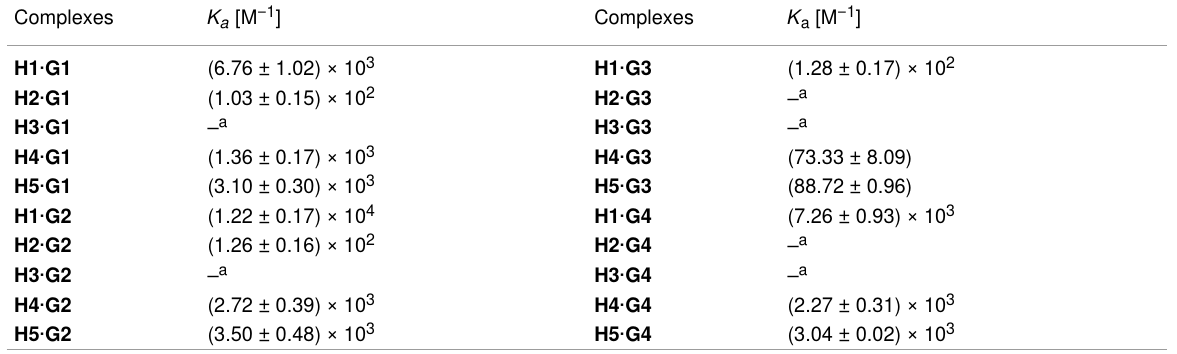
Table 1: Association constants ( K a ) for 1:1 host–guest complexes in CDCl 3 /acetone- d 6 1:2 (v/v) at 298 K. Complexes K a [M − 1 ]